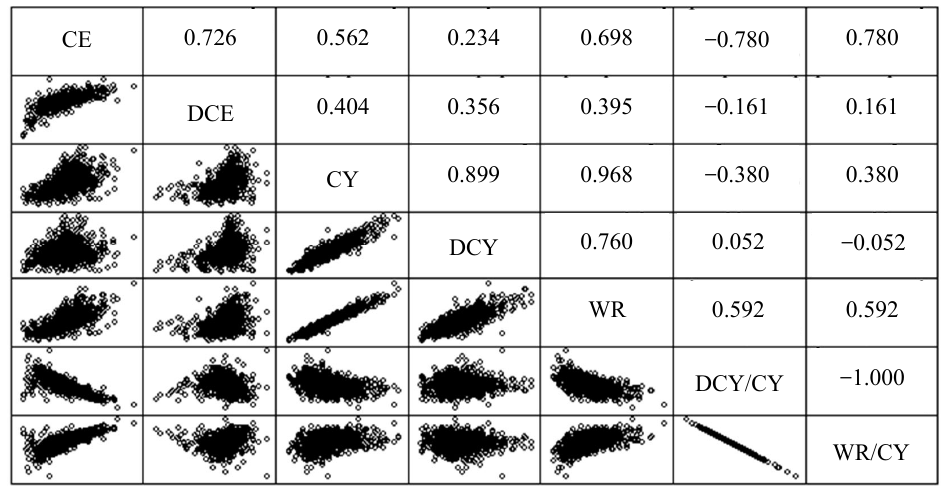
Figure 3. Frequency distribution of curd efficiency (CE) and dry curd efficiency (DCE) in Manchega sheep milk ( n = 967).